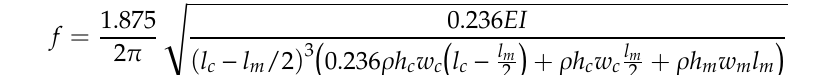
Figure 1. Basic structure of proposed acceleration sensor in two models: ( a ) Model I; ( b ) model II.